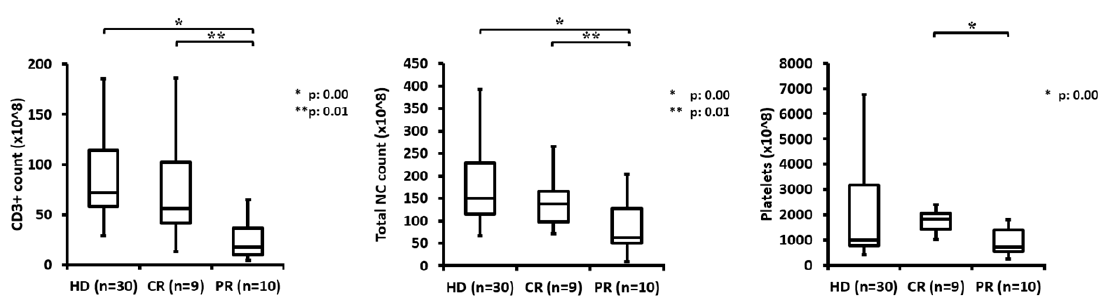
Figure 6. Comparison of leukapheresis products from healthy donors and patients by remission status. Total NC count, CD3+ count, and platelets are compared between healthy donors ( n = 30) and patients receiving axicabtagene ciloleucel, sorted by response.